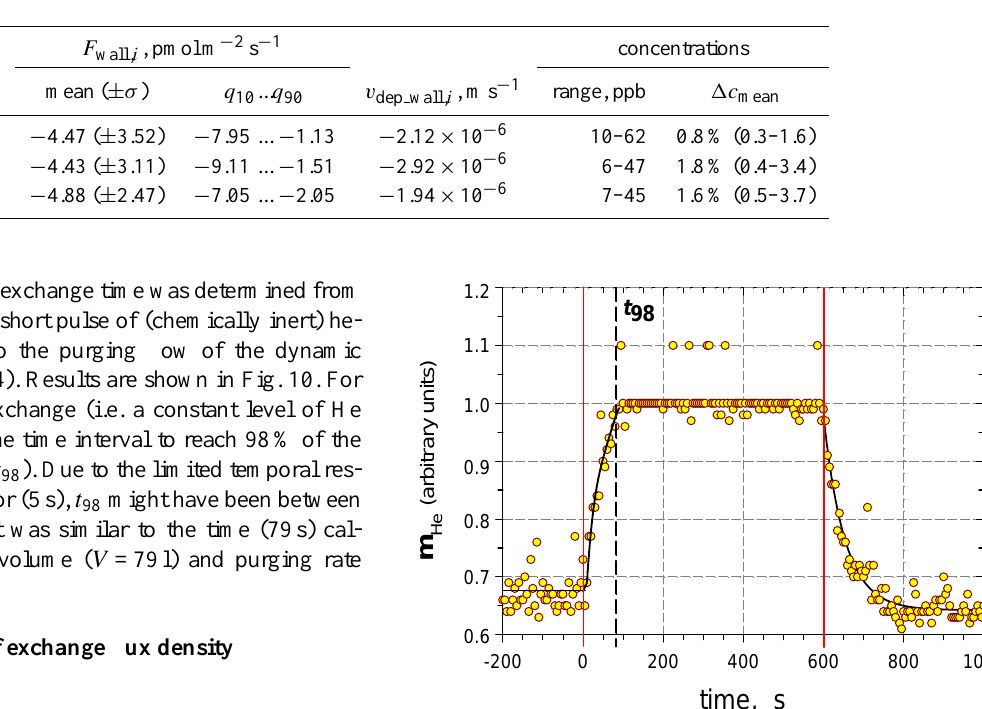
Figure 10. Results of the response time test with helium. The chamber ( V = 0.079 m 3 ) was operated with purging air flow rate Q = 60 L min -1 . The red lines represent start and end of the helium addition, the black dashed line marks the end of equilibration. For the approximation of a complete exchange we used the time interval for 98 % approximation ( t 98 ).